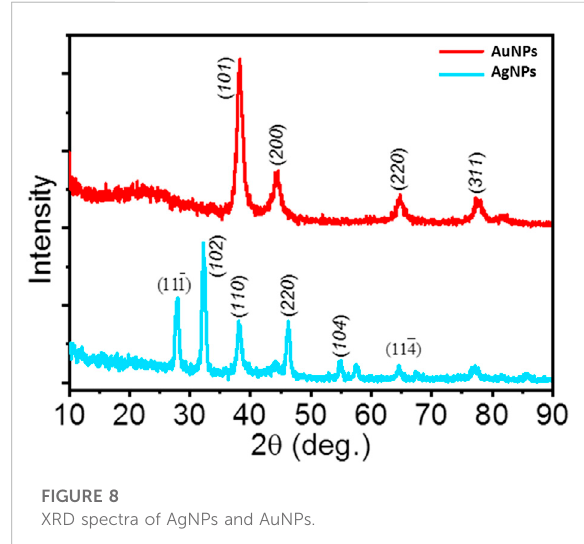
FIGURE 8 XRD spectra of AgNPs and